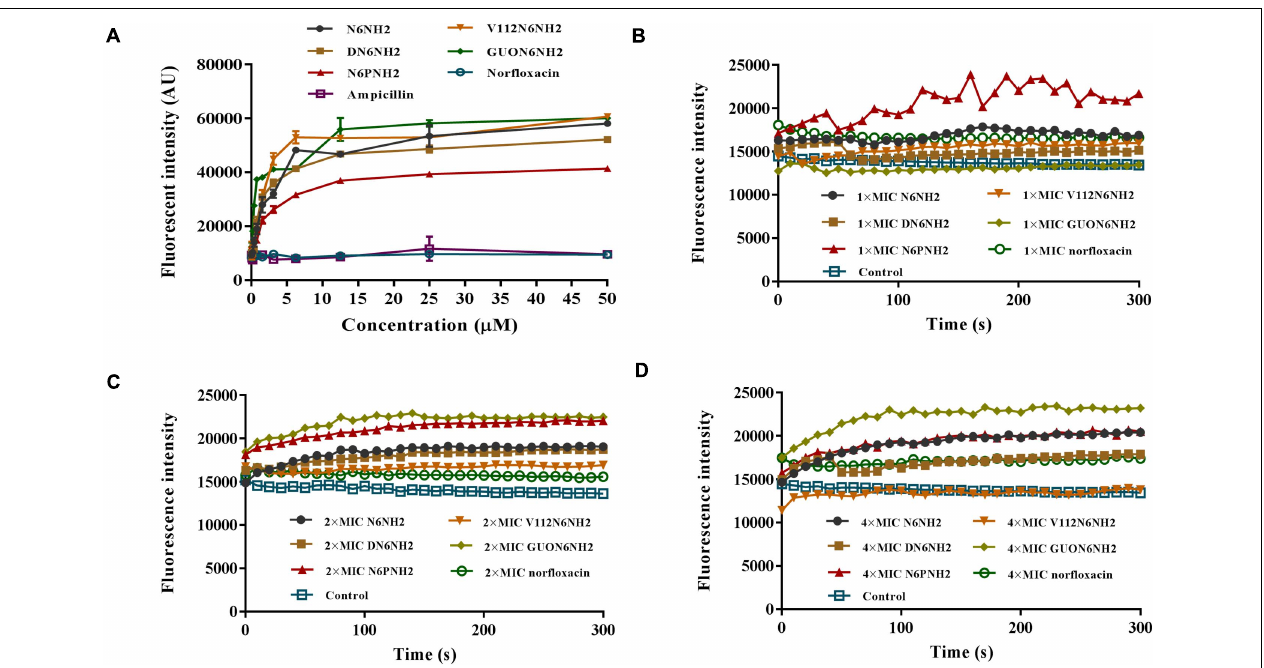
FIGURE 3 | Interaction of N6NH2 and its derivatives with LPS and outer membrane of E. tarda . (A) Interaction of peptides with LPS (ability of LPS to displace a peptide-bound BC probe). All peptides showed a strong binding affinity for LPS. (B–D) Interaction of peptides with outer membrane of E. tarda . Bacterial cells were treated with 1 × (B) , 2 × (C) , and 4 × MIC (D) , respectively, and observed with a microplate reader. GUON6NH2 exhibited a stronger ability to penetrate bacterial outer membrane than other